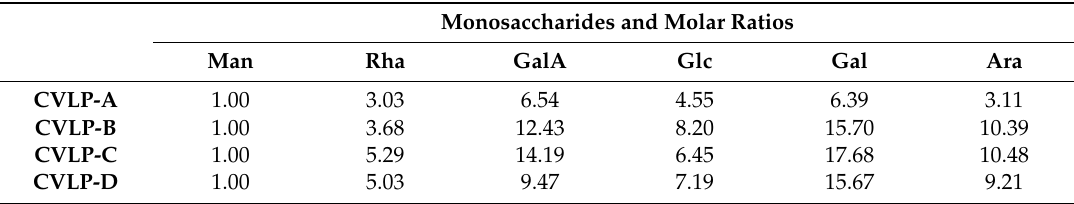
Table 3. Molar ratios of constituent monosaccharides of CVLPs.